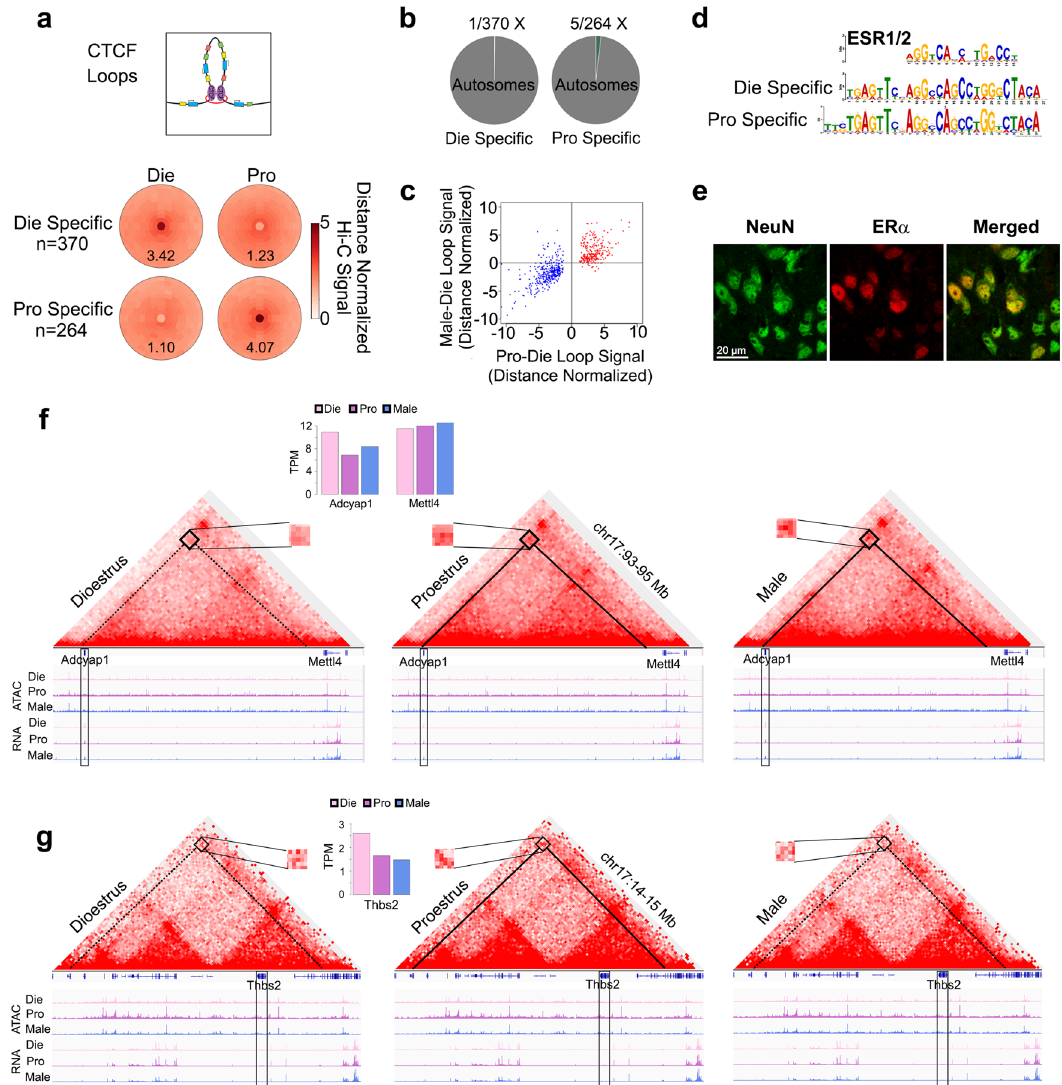
Fig. 4 Oestrous cycle-dependent CTCF loops in vHIP neurons. Oestrous cycle stage-dependent, Die- and Pro-speci fi c loops ( a ) are primarily located on autosomes ( b ); Pro-Die loop signal goes in the same direction as Male-Die signal ( c ). Die- and Pro-speci fi c loops are enriched for the ER α (ESR1) motif (E values 1.1e − 62 and 2.5e − 58, respectively) ( d ). ER α localises to NeuN + nuclei in the ventral hippocampus ( e , representative proestrus sample is shown; n = 3 animals/group; scale bar: 20 μ m). Two example genes Adcyap1 ( f ) and Thbs2 ( g ) are presented. Differential loops are depicted with either a solid line (strong loop) or dashed line (weak loop). IGV tracks show merged ATAC-seq and RNA-seq data with the corresponding loops for dioestrus (Die), proestrus (Pro), and males (Male) derived from 3 biological replicates for each group. Insets show gene expression for Adcyap1, Mettl4 (neighbouring gene), and Thbs2 . Die, pink; Pro, purple; Male,